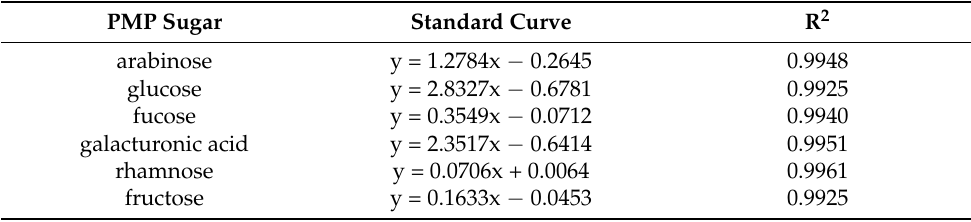
Table 1. Calibration curves for the 1-phenyl-3-methyl-5-pyrazolone (PMP)